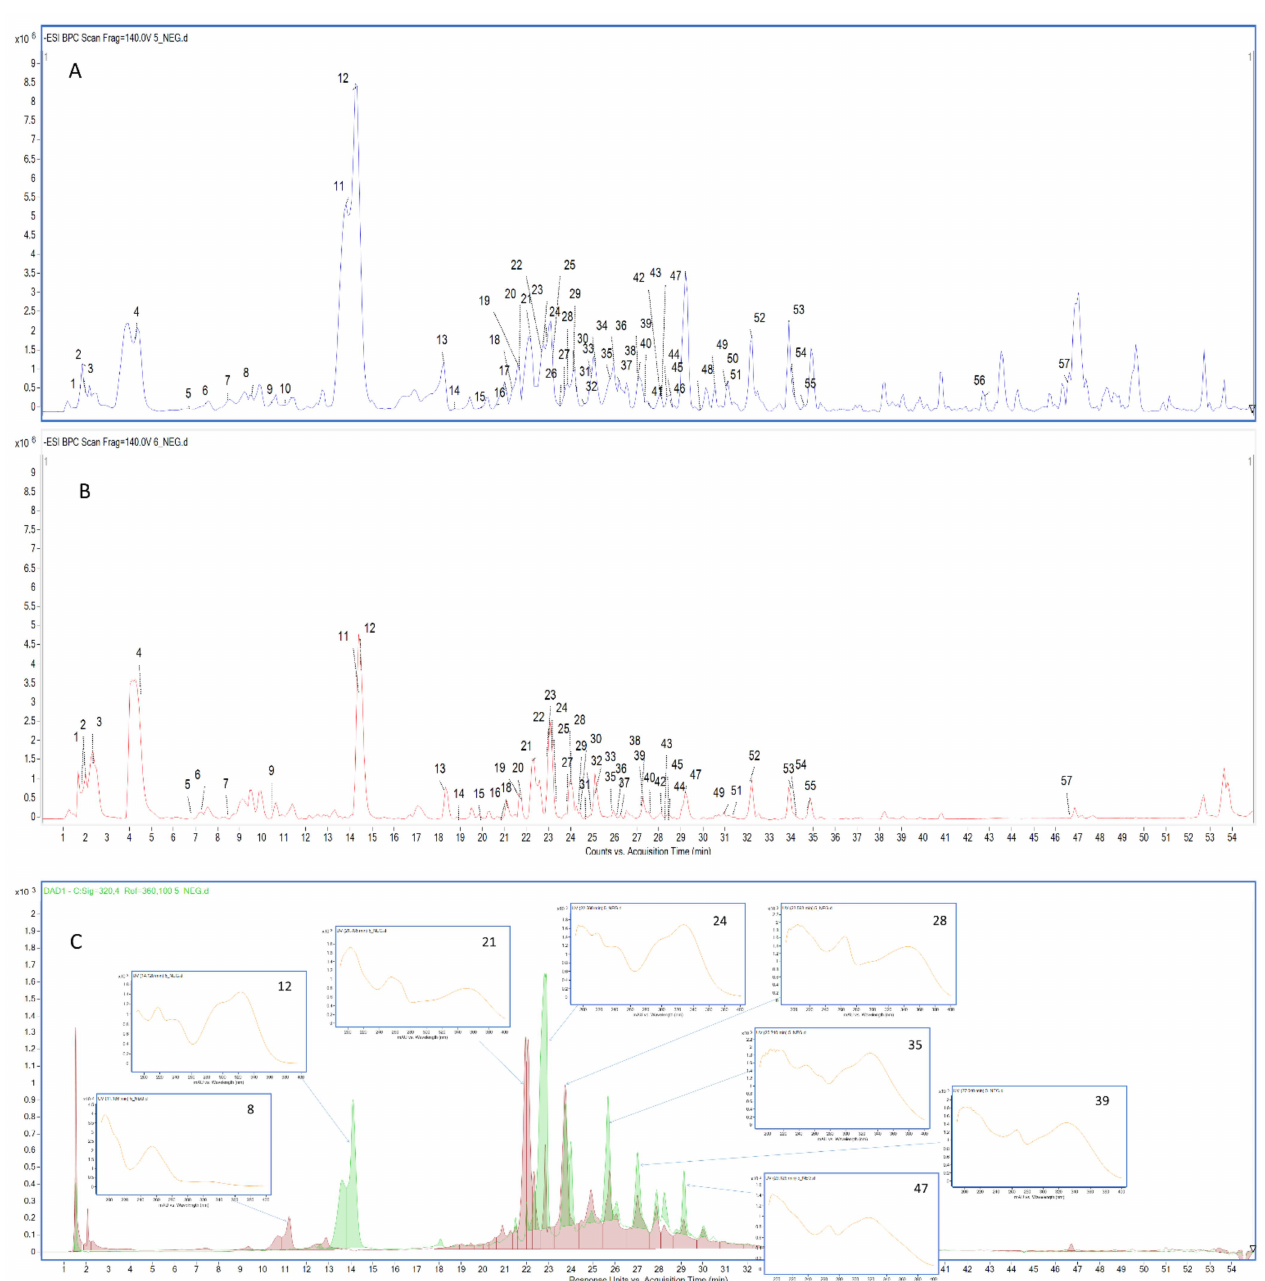
Figure 1. Spectrochromatographic profile of leaf–MeOH ( A ) and leaf infusion ( B ) extracts; num- bers correspond to compounds listed in Table 1. ( C )—UV chromatograms of leaf–MeOH extract: violet—254 nm; green—320 nm. UV spectra for most the abundant compounds are